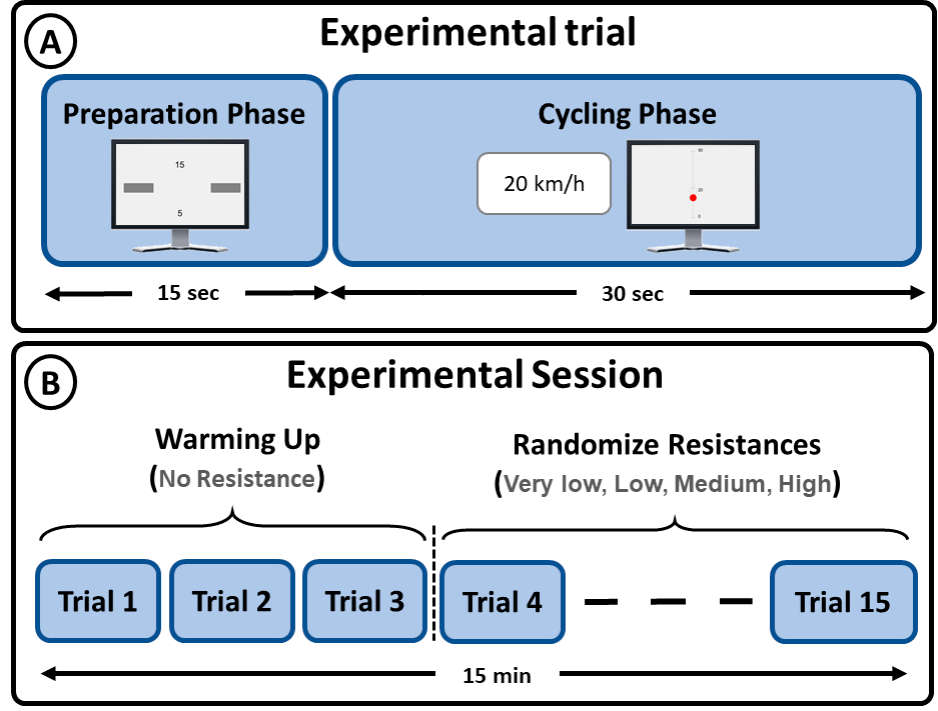
Figure 2. Experimental protocol: ( A ) experimental phases and duration; ( B ) repetitions and total duration of the experi- ments.